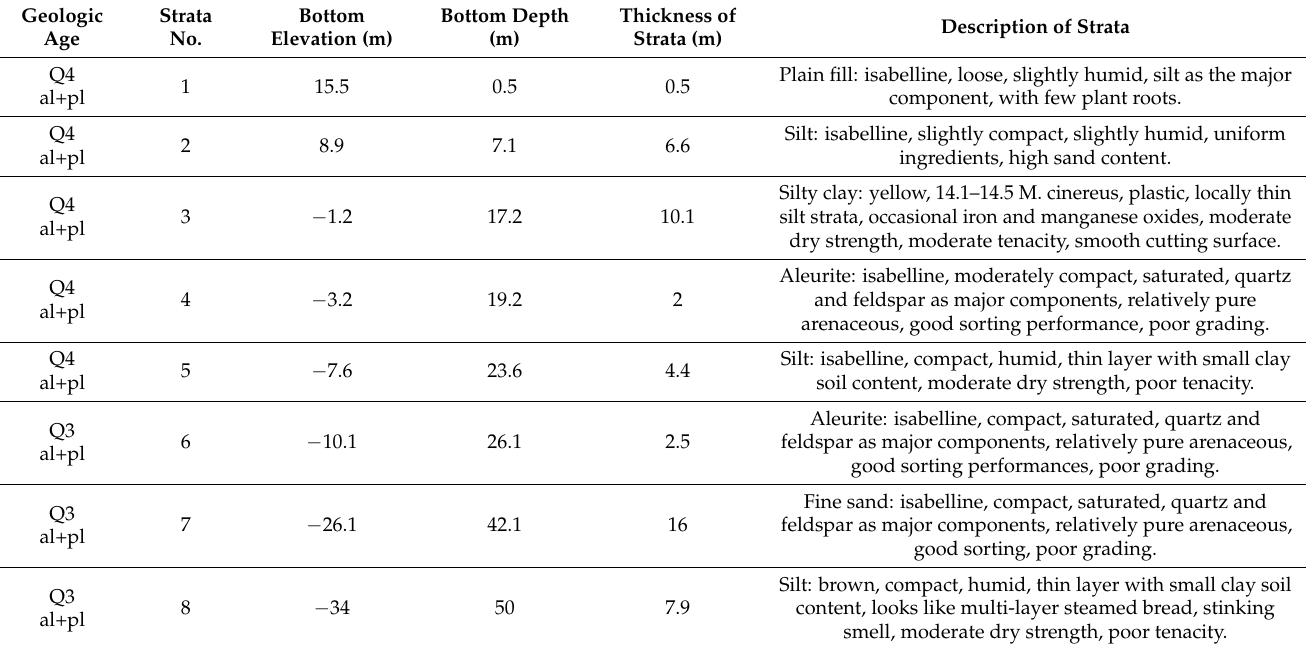
Table 2. Thickness and soil properties of different strata in the test